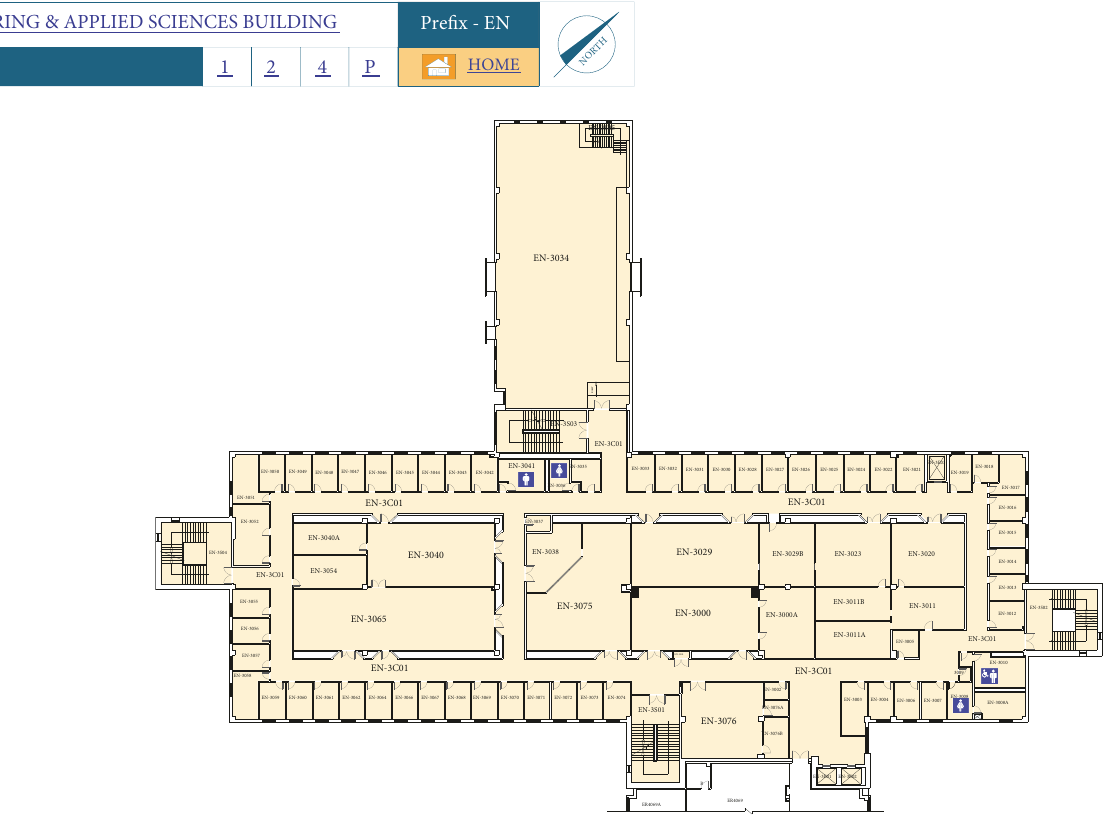
Figure 3: The third floor of the building.